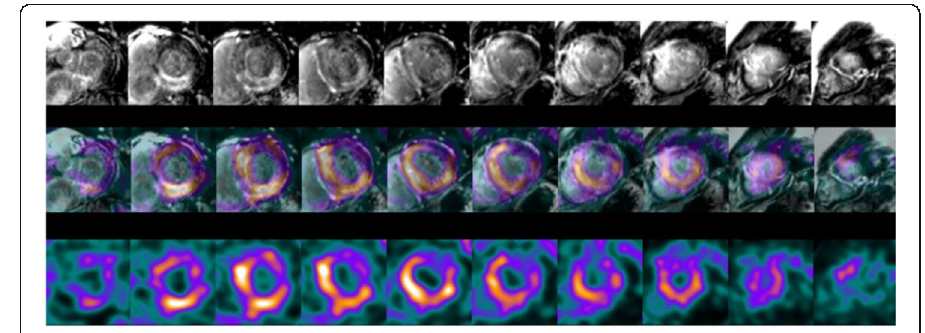
Fig. 3 Positive Tc-HDP xSPECT images coregistered to delayed gadolinium enhanced short axis CMR images in a patient with ATTR cardiac amyloid showing the distribution within the myocardium. HDP uptake colocalises to sites of LGE (white regions within myocardium on CMR)